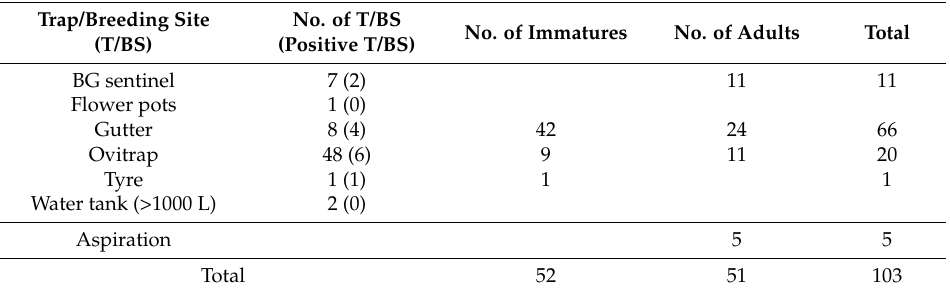
Table 1. Number of set traps, screened larval habitats, adult mosquitoes collected by aspiration in the surveillance plan after detection of Ae. albopictus (number of positive traps/breeding sites for Ae. albopictus in brackets), and specimens collected from 12 June to 20 December 2017. Trap/Breeding Site (T/BS)